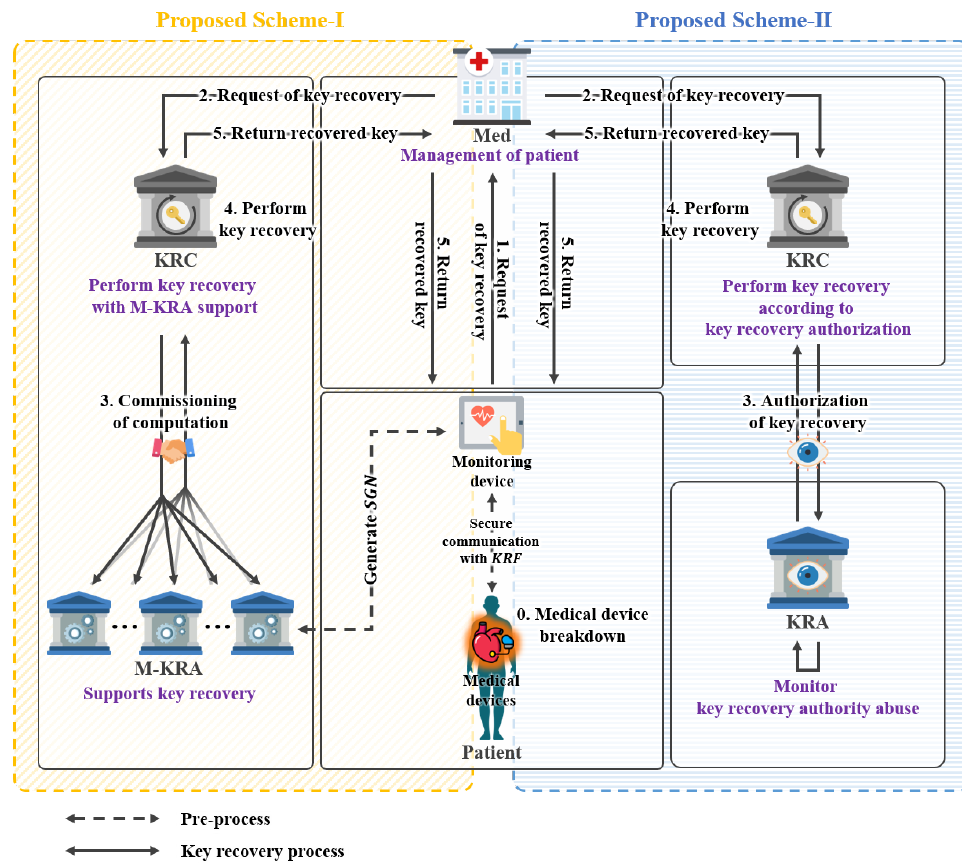
Figure 1. Summary and comparison of proposed key recovery system